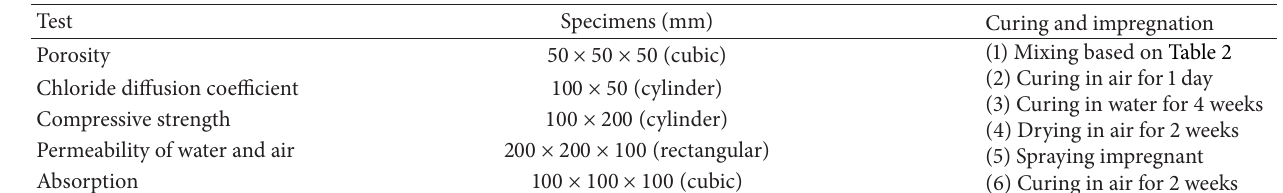
Table 4: Specimens and curing